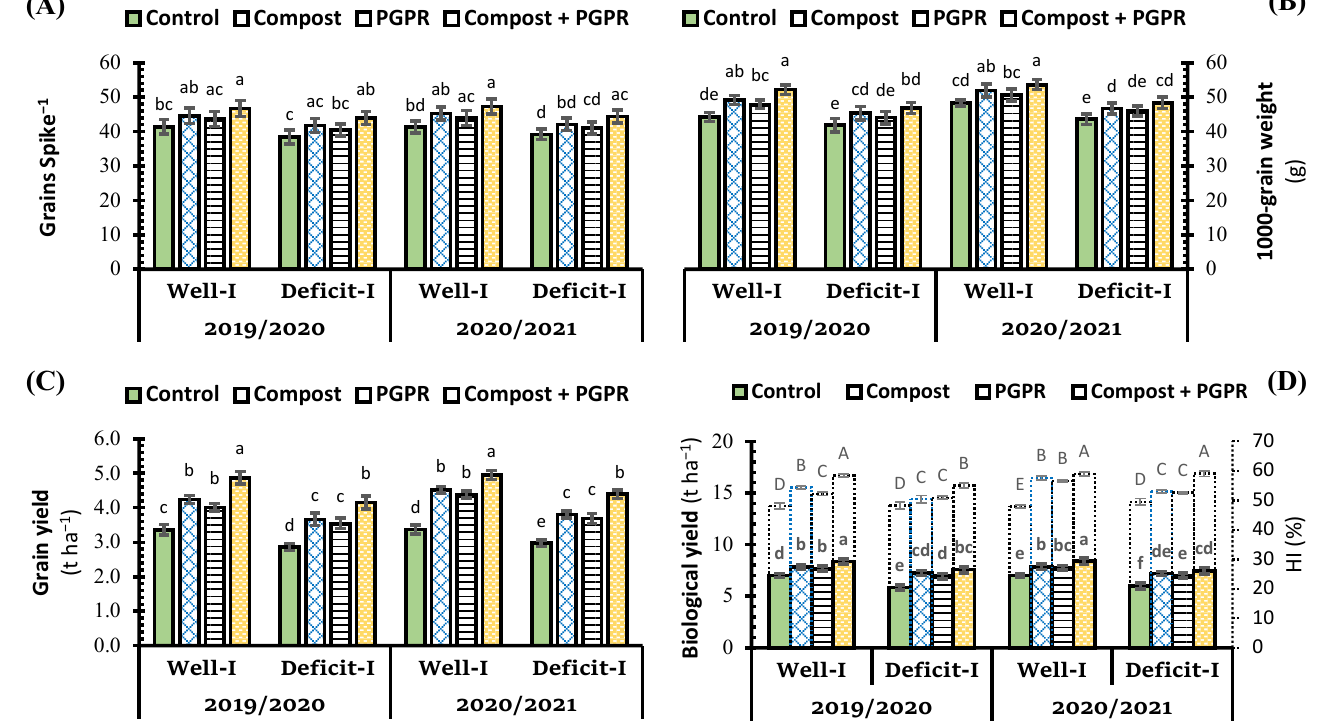
Figure 5. Influence of soil amendment with compost and plant growth-promoting rhizobacteria (PGPR) on the grain yield traits ( A ) grain spike −1 , ( B ) 1000 grain weight, ( C ) grain yield, and ( D ) biological yield and harvest index (HI) of wheat plants grown in salt-affected soil and deficit irrigation in contrast to well irrigation. The error bars present the values of standard deviation. According to Duncan’s multiple range test, the same lower-case letters above columns are not significantly different ( p < 0.05), while the upper-case letters in figure ( D ) presented the significant differences between means of HI.